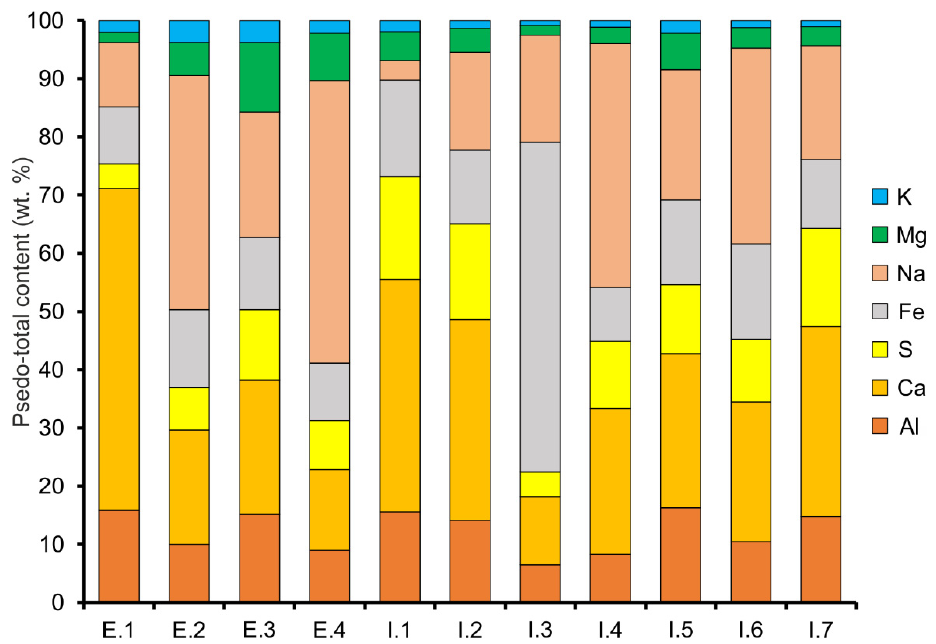
Figure 8. Mass percentage of major elements in dusts sampled at the consecutive sites. Sodium (Na). The concentration of Na showed the most significant spatial variation across sampling sites. Similar to halite distribution, Na content increased at the beginning of atmospheric airflow in the mine: the maximum content of Na was measured at site E.4. At all locations in the mine interior (I.2–I.7), the Na content was higher than the values at site I.1.